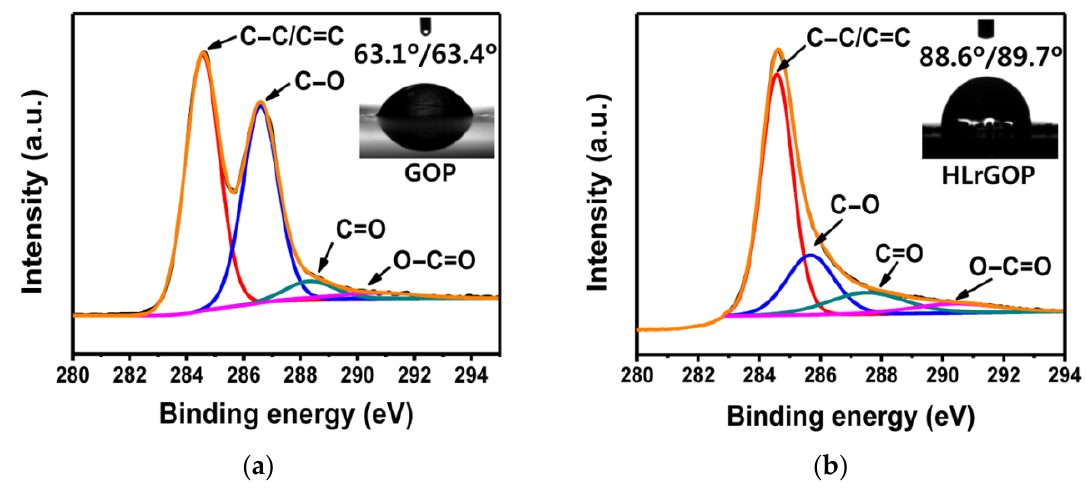
Figure 14. X-ray spectroscopic data showing C1s peaks and contact angle corresponding to ( a ) wettability of the GO paper with water and ( b ) non-wettability of the GO paper reduced by laser. Reproduced from [37] with permission from American Chemical Society. Copyright 2014.